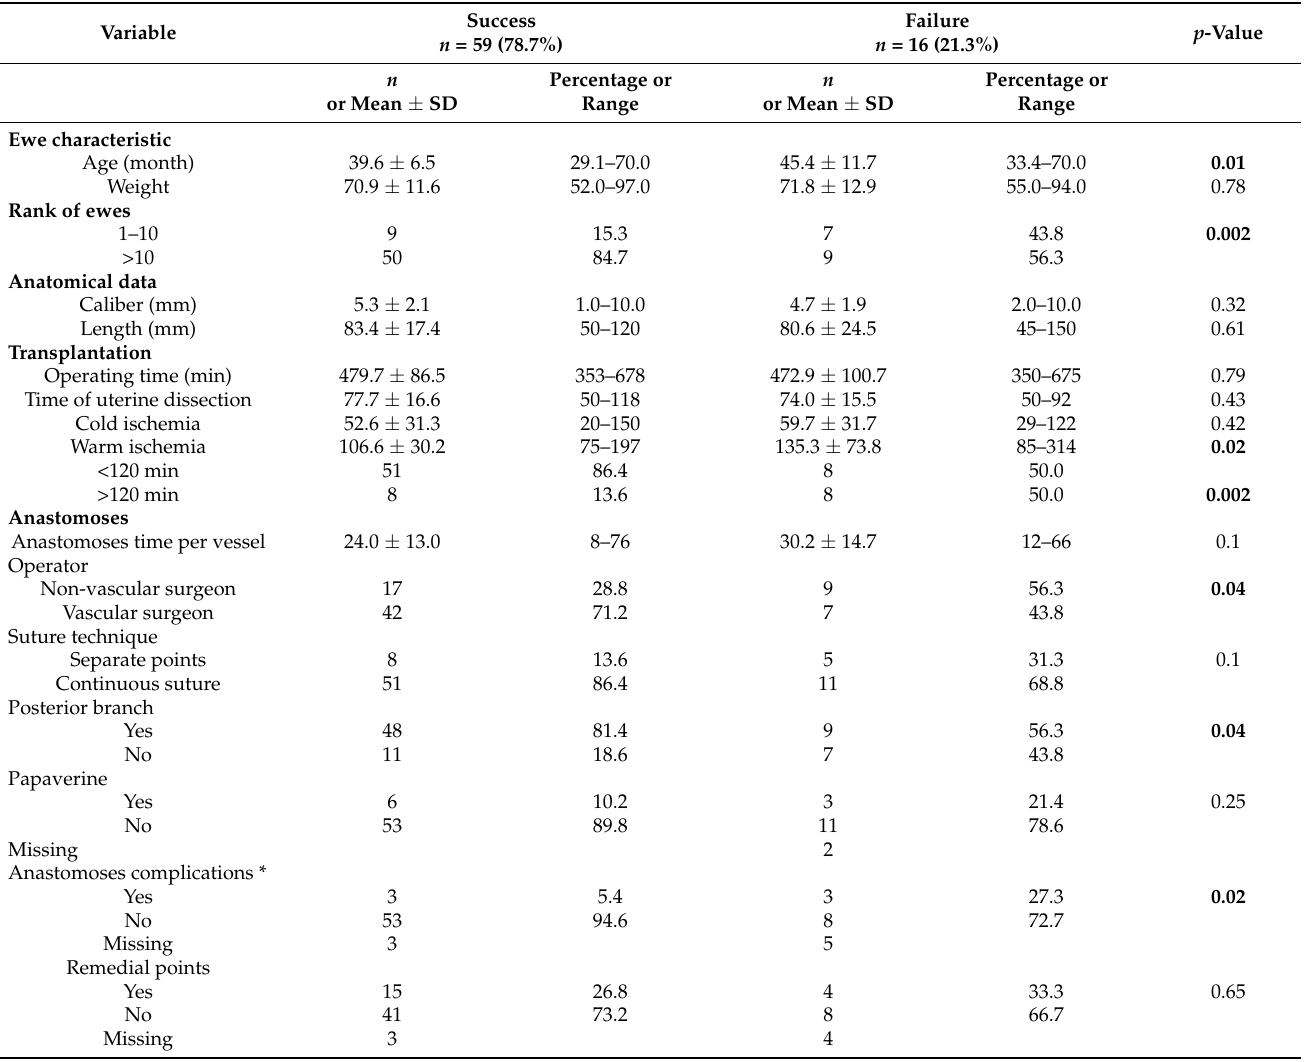
Table 1. Predictive factors for successful arterial anastomoses in the immediate postoperative